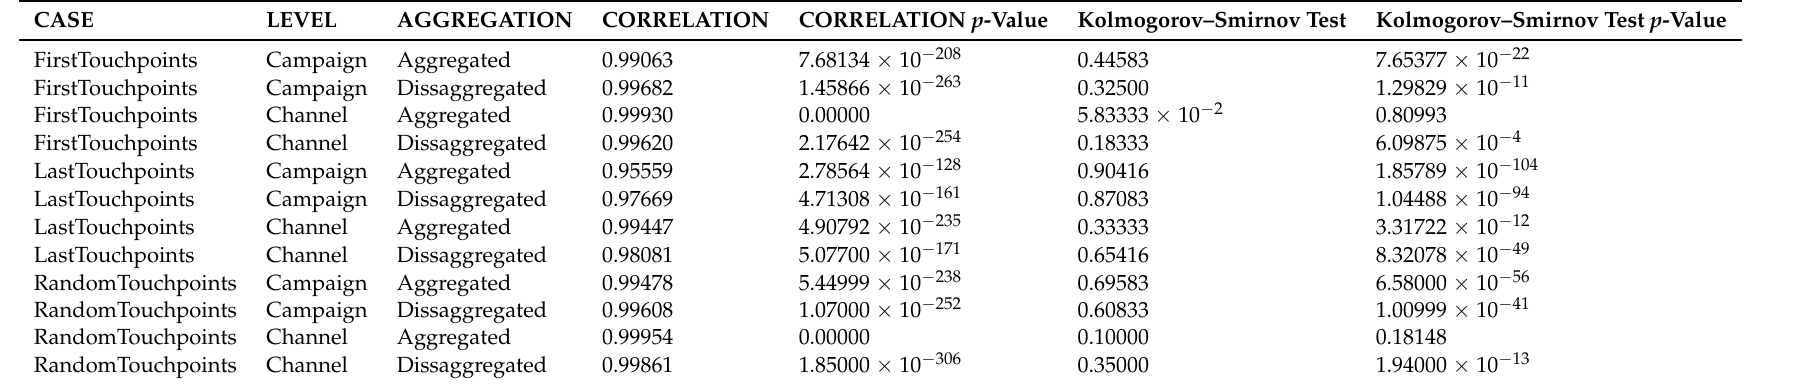
Table A2. This table shows the correlation and Kolmogorov–Smirnov test for Figure 4.